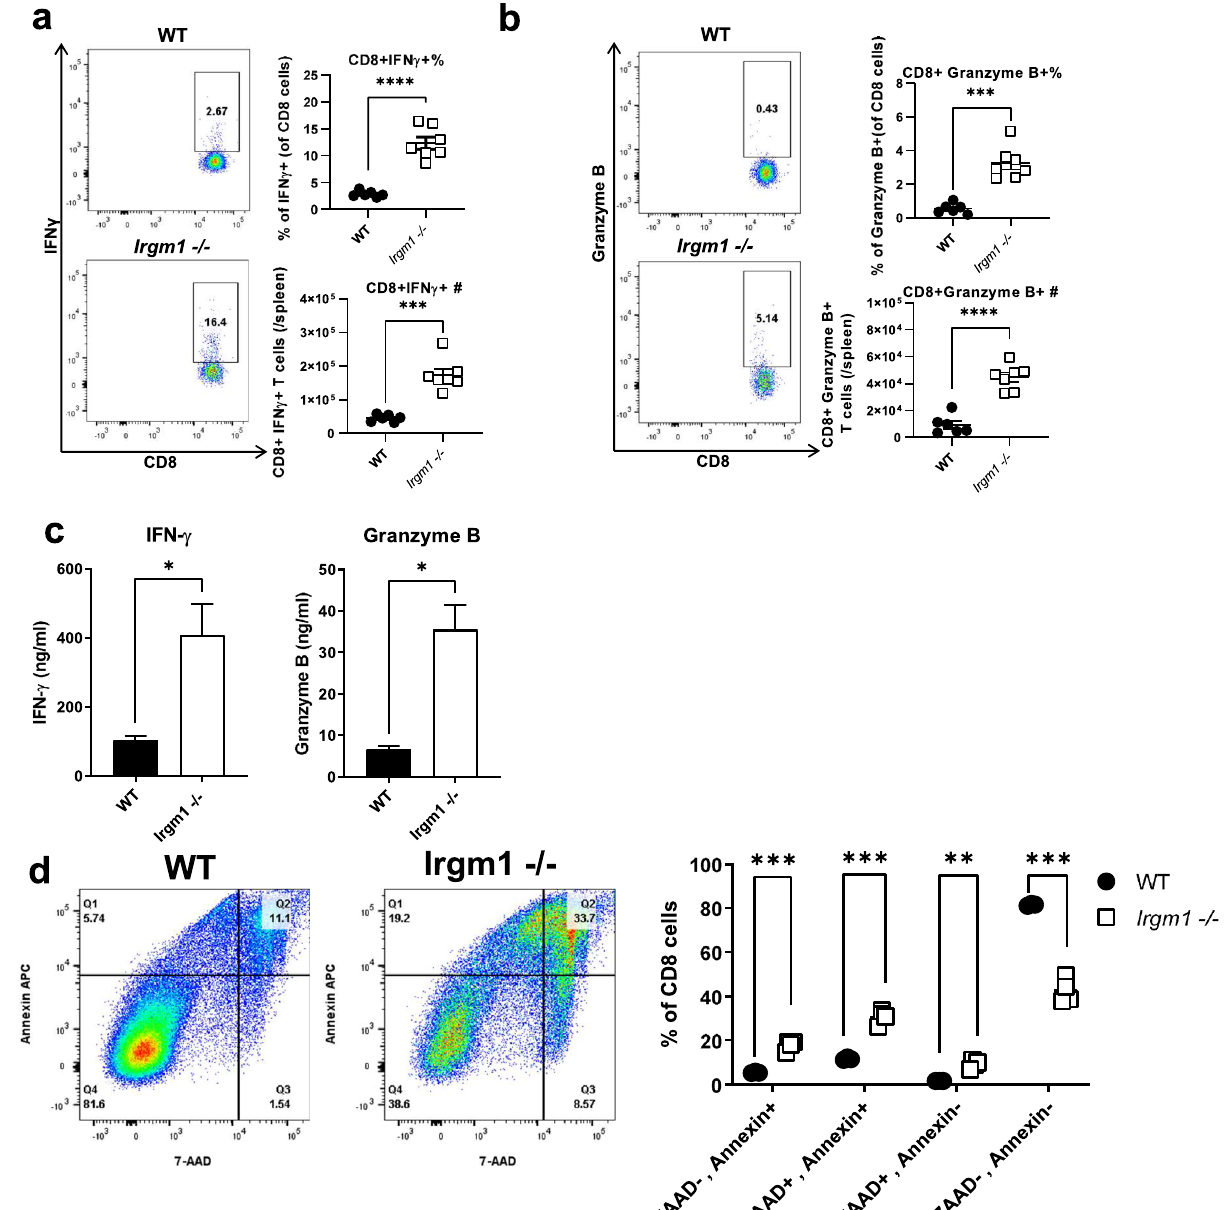
Figure 3. Irgm1 deficiency is associated with CD8 + T cell cytokine overproduction and increased apoptosis. ( a-b ) Splenocytes were isolated from WT and Irgm1 −/− mice, stained and analyzed by flow cytometry for CD8 + IFNγ + ( a ) and CD8 + Granzyme B + ( b ). ( c ) CD8 + T cells were isolated and activated for 48 h with plate bound anti-CD3 and anti-CD28 antibodies after which the media was collected and IFNγ and Granzyme B were measured by ELISA. ( d ) Activated CD8 + T cells were assayed for the presence of apoptotic cells, measuring 7-AAD and annexin V positive cells by flow cytometry. (a,b) Data pooled from two independent experiments ( n = 6–7 ), (c, d) data representative of two independent experiments ( n = 3–4 ); error bars represent ± SEM. Mann Whitney test or T-test with Welch’s correction was used to compare groups depending on the normality of the distribution as judged by the Shapiro–Wilk test. * p < 0.05, ** p < 0.01, *** p < 0.001, **** p <